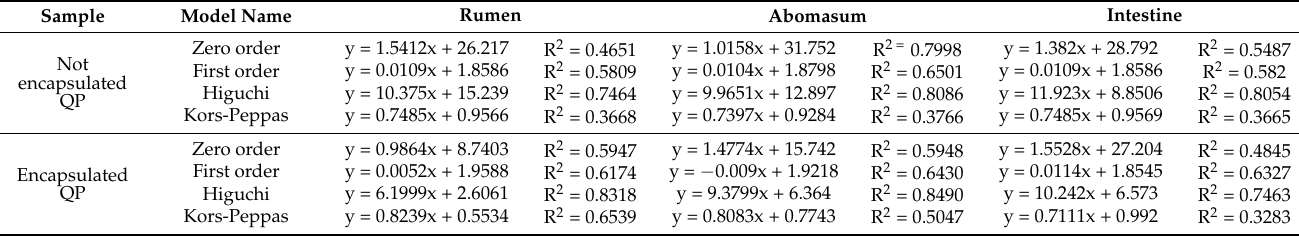
Table 4. Kinetic release parameters of not encapsulated and encapsulated extract in various elution